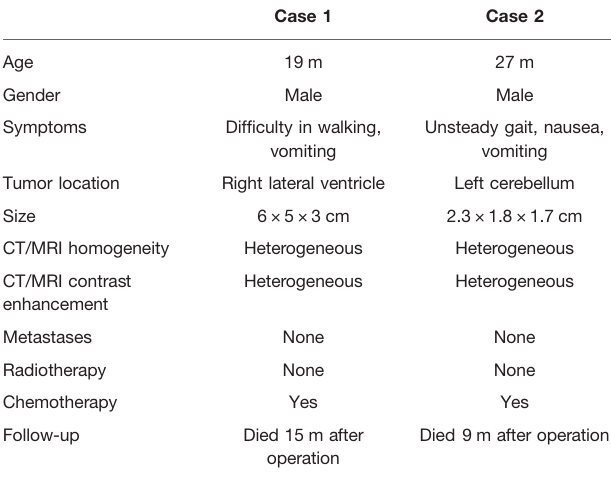
TABLE 1 | Clinical features, imaging fi ndings, and therapy in two cases of AT/ RTs.